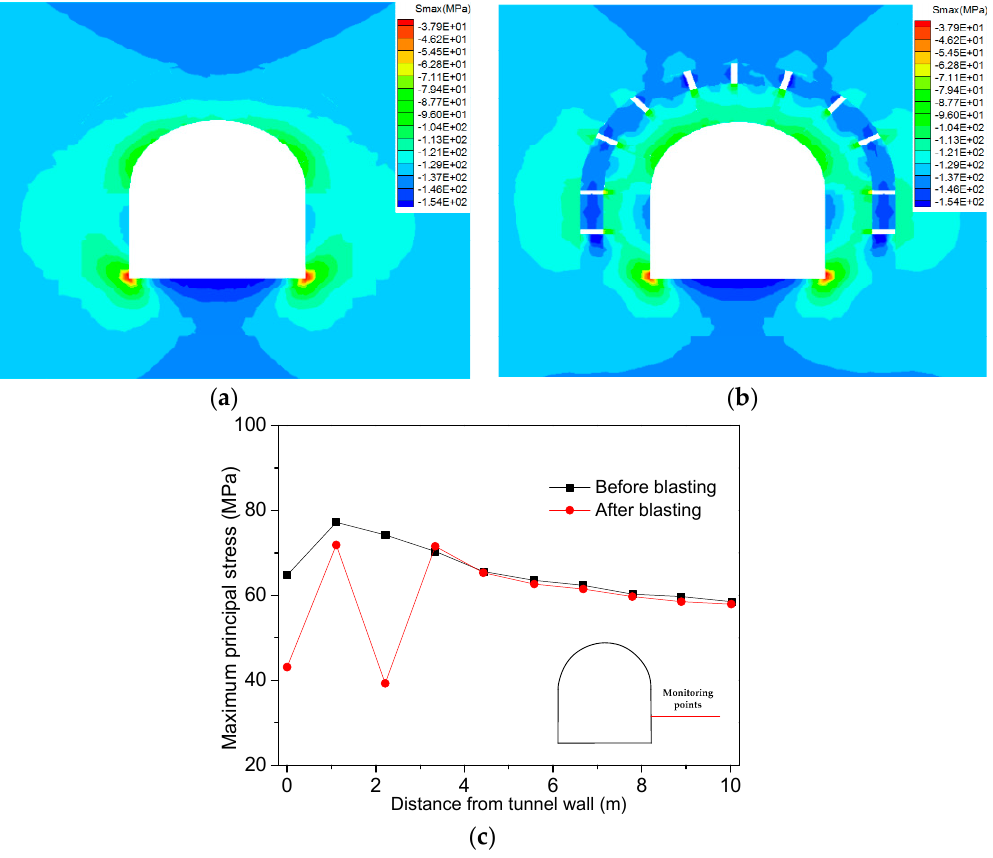
Figure 11. The change of maximum principal stress in surrounding rock before and after blasting: